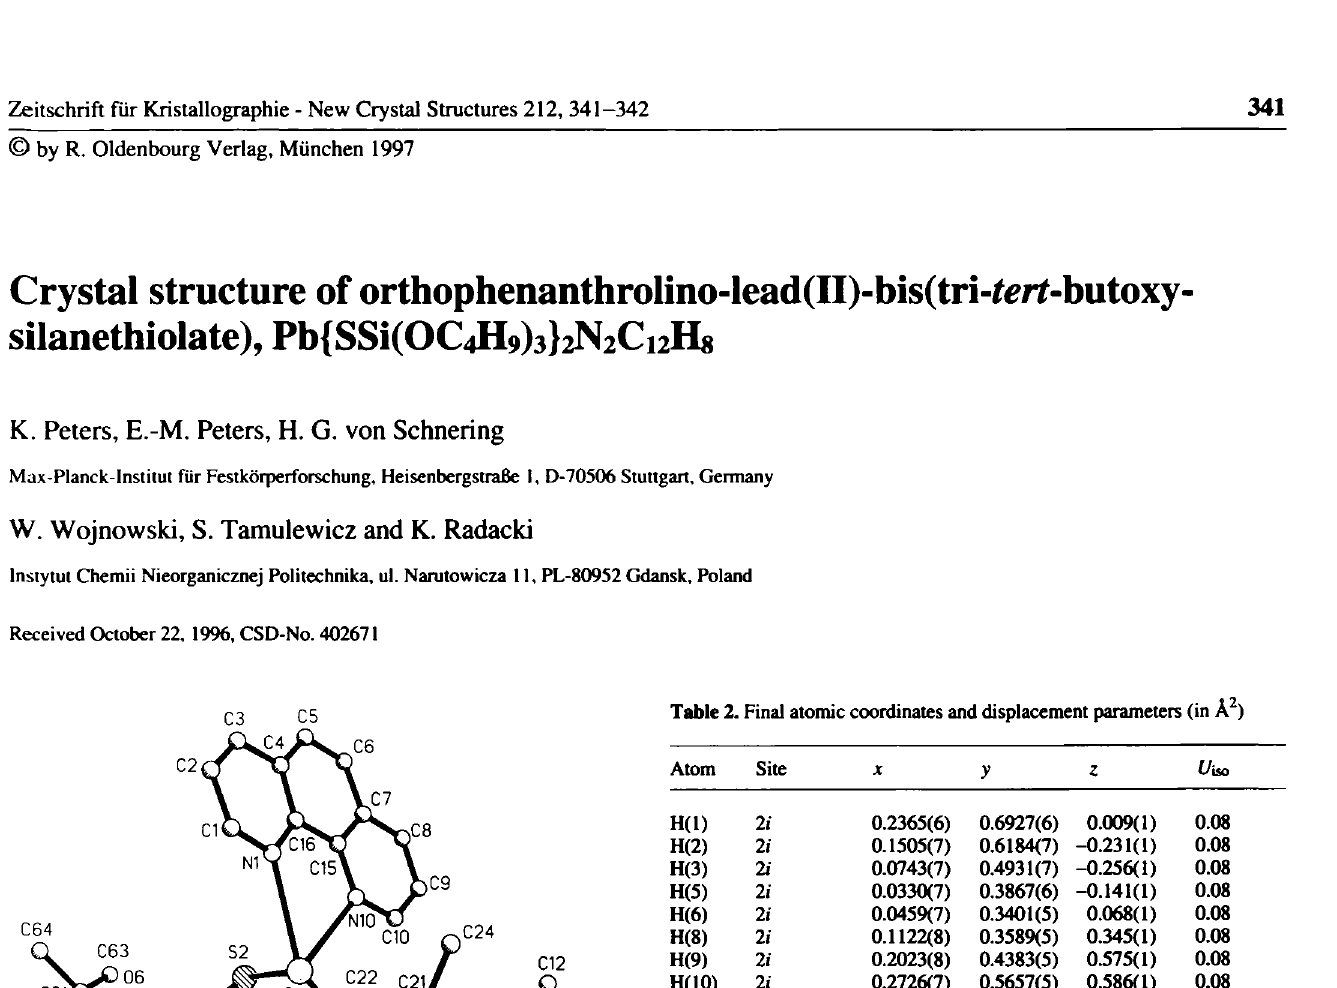
Table 2. Final atomic coordinates and displacement parameters (in A 2